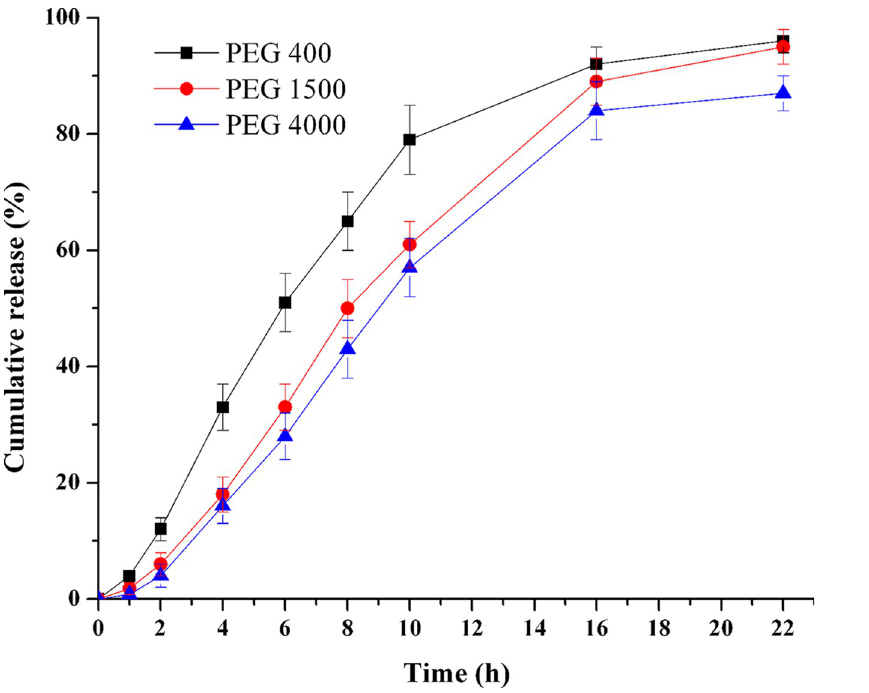
Fig 9. Effect of PEG molecular weight in coating membrane on TPM release (n =